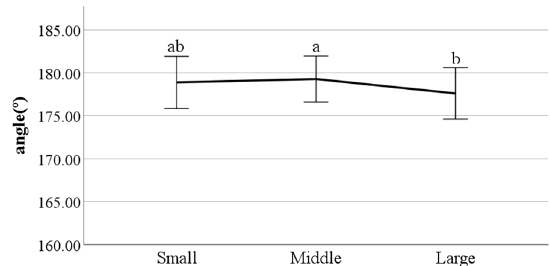
Figure 33. Head movements in the frontal plane at the double support phase (left foot forward) (F value: 5.90, DF: 2, p -value: 0.00).